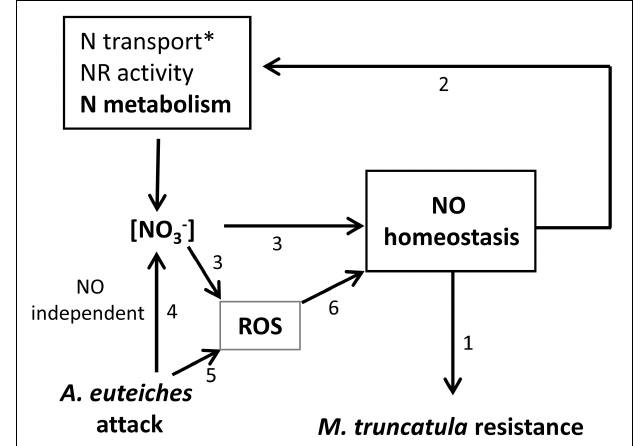
FIGURE 6 | Working model. Results from the present work indicate that RNAi::MtNIA1/2 and 35S::GSNOR transformed roots are, respectively, more susceptible and more resistant to A. euteiches (1). NR activity and NO 3 − content were impacted by GSNOR overexpression, indicating a possible effect of GSNOR on basal NO 3 − transport/assimilation (2). NO 3 − availability in the medium causes quantitative modulation of ROS/RNS/NO content and affects their balance (3). Infection by A. euteiches decreases root NO 3 − content (4) and induces higher ROS levels (5). According to the literature superoxyde (O 2 ·− ), by reacting with NO to form peroxynitrite, can influence the concentration of NO available for signaling (6). ∗ : GSNO was shown to regulate NO 3 − uptake through transcriptional regulation of NRT2.1 (Frungillo et al.,